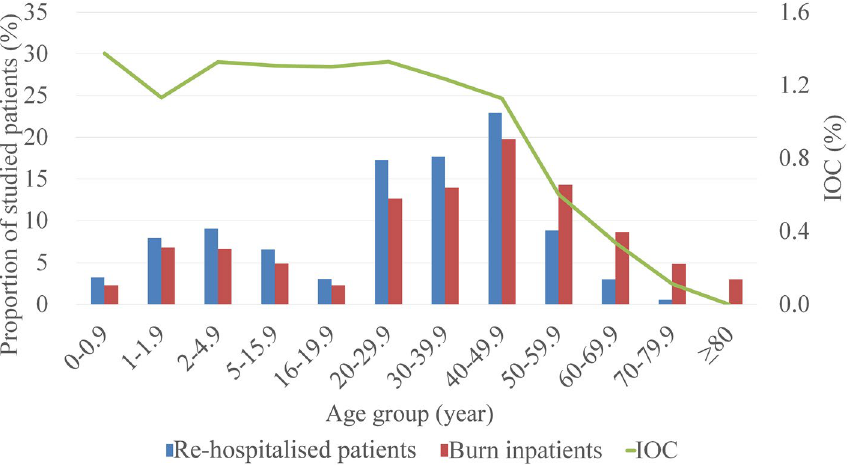
Figure 2. Proportions of burn inpatients and scar contracture-associated re-hospitalised inpatients along with IOC in age groups. The X-axis represents to the age groups classified according to the 2016 United States National Burn Repository . The left Y-axis corresponding to the bars represents the proportion of each group in the studied population. The right Y-axis corresponding to the line graph represents the IOC values. Abbreviation: IOC the incidence of scar contracture associated re-hospitalisation.